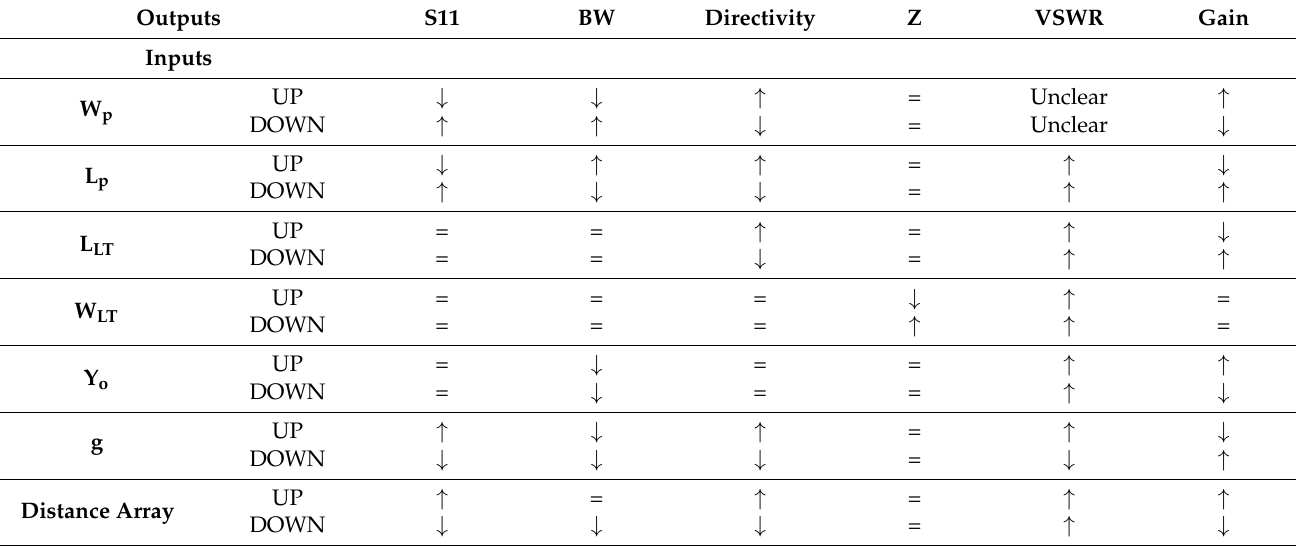
Table 11. Result of the study of simulating the InsetFeed antenna with different input